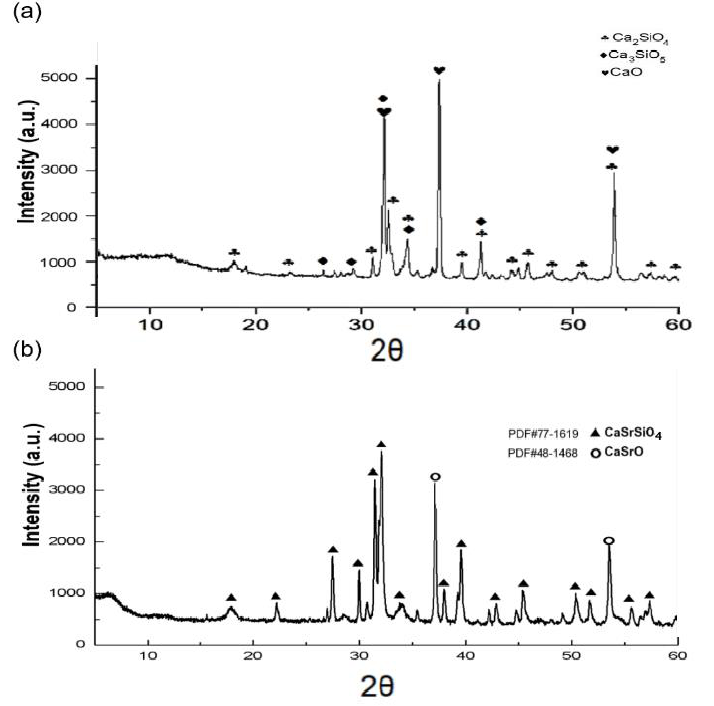
Figure 1. Crystallographic characterization of the synthesized materials. ( a ) XRD patterns of CS exhibiting diffraction peaks of Ca 2 SiO 4 as the major phase, Ca 3 SiO 5 , and CaO as minor phases. ( b ) XRD phase identification of CSR showing the typical characteristic peaks of CaSrSiO 4 , and two minor peaks of CaSrO.